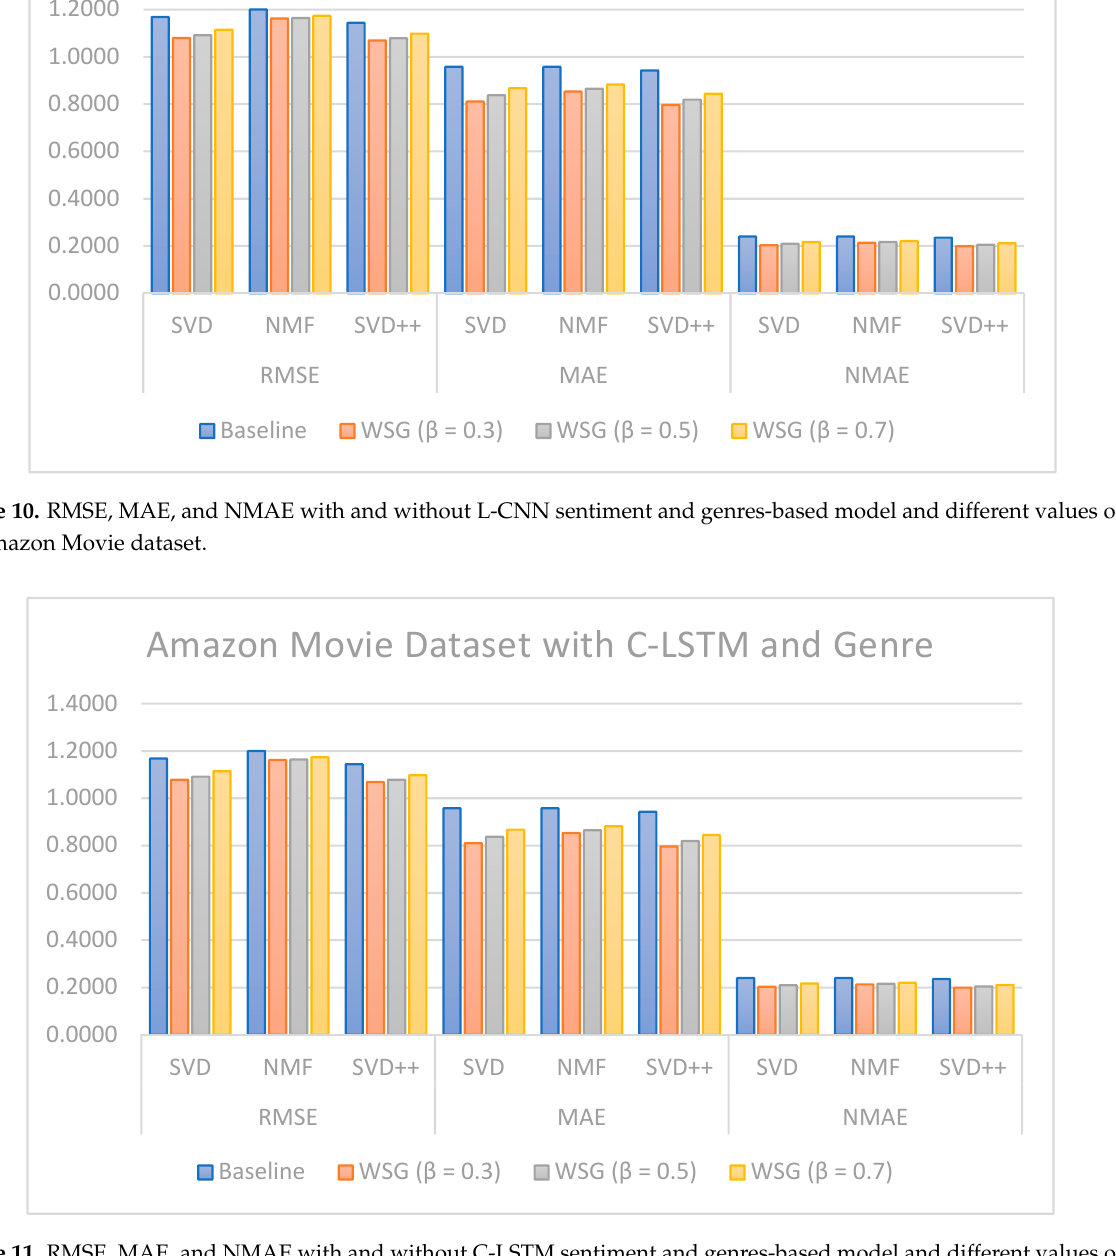
Figure 11. RMSE, MAE, and NMAE with and without C-LSTM sentiment and genres-based model and different values of β on Amazon Movie dataset.